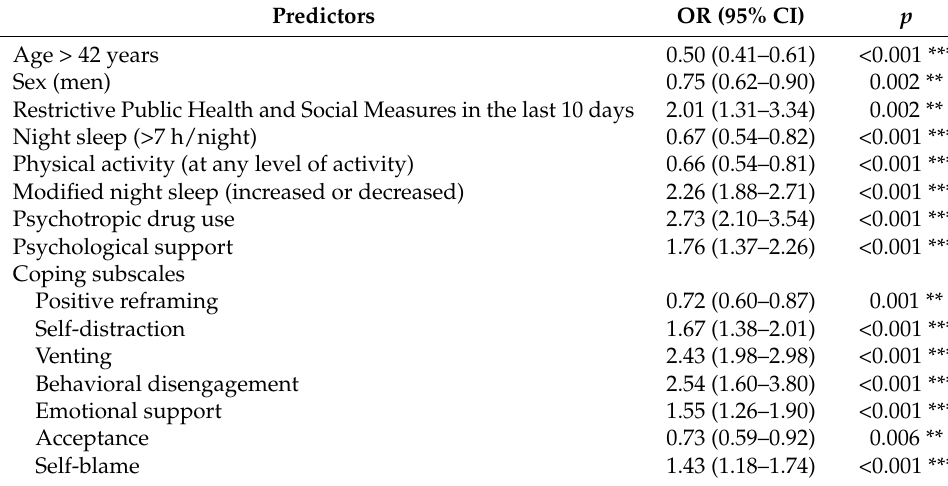
Table 3. Multivariate logistic regression analysis of factors associated with moderate-to-severe anxiety (GAD-7 Score ≥ 10).